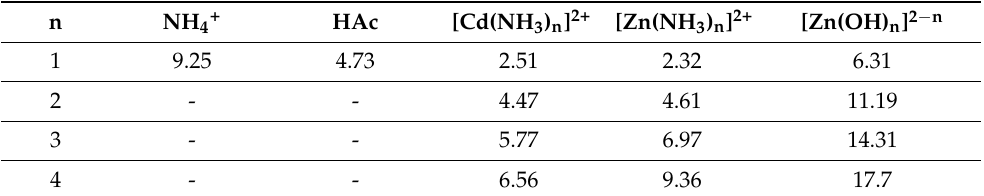
Table 2. Overall stability constants used for the calculation of the initial free metal ion concentra- tions [42,43].